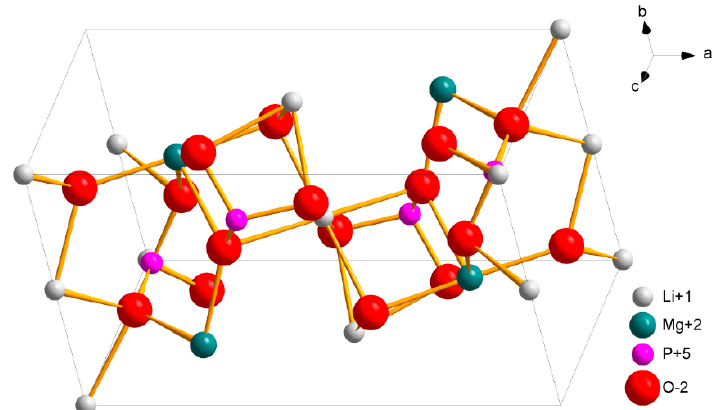
Figure 1. 3D crystal structure of LiMgPO 4 prepared by Diamond 4.1 software using the data from Crystallographic Open Database (COD 1530053). View towards the <h,k,l> = <1,1,1> plane.